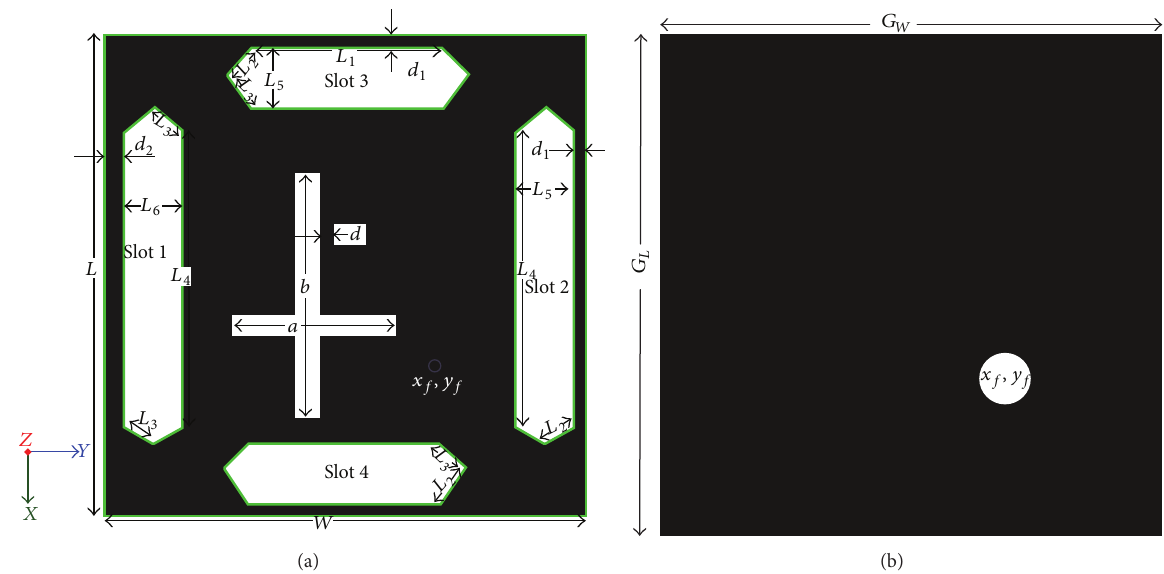
Figure 1: Proposed antenna geometry layout: (a) top view and (b) bottom view.